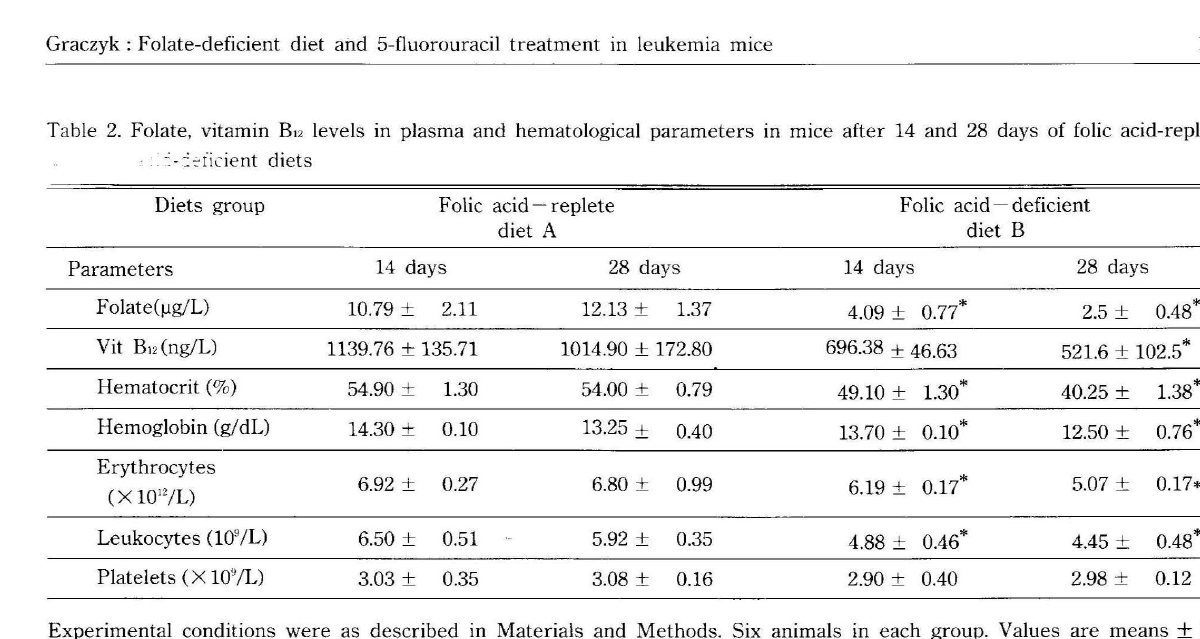
Table 2. Folate, vitamin BI2 levels in plasma and hematological parameters in mice after 14 and 28 days of folic acid-replete ".:: :"ficient diets Diets group Folic acid -